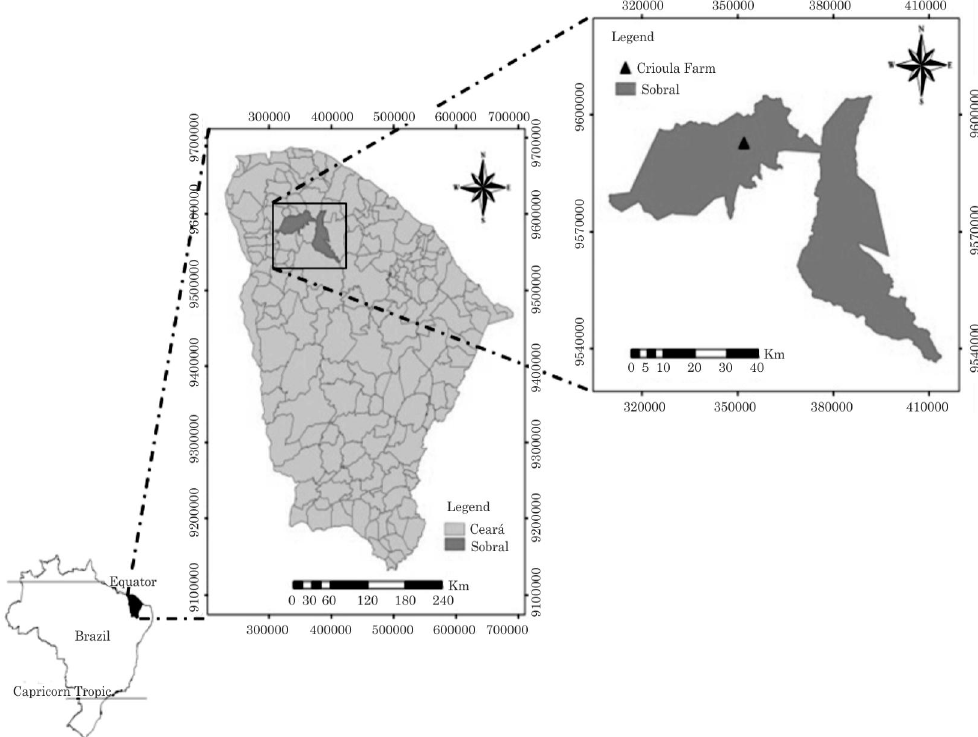
Figure 1. Location of the experimental area in the Crioula farm, Embrapa/CNPC, Sobral, Ceará, Brazil.